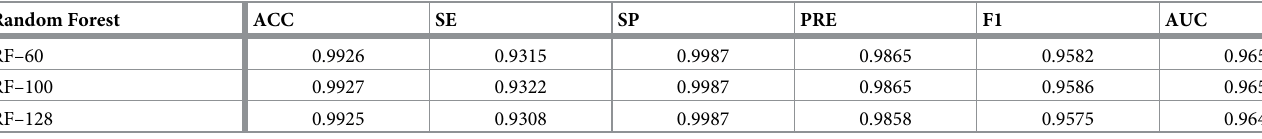
Table 5. Random forest results (1 st experiment).